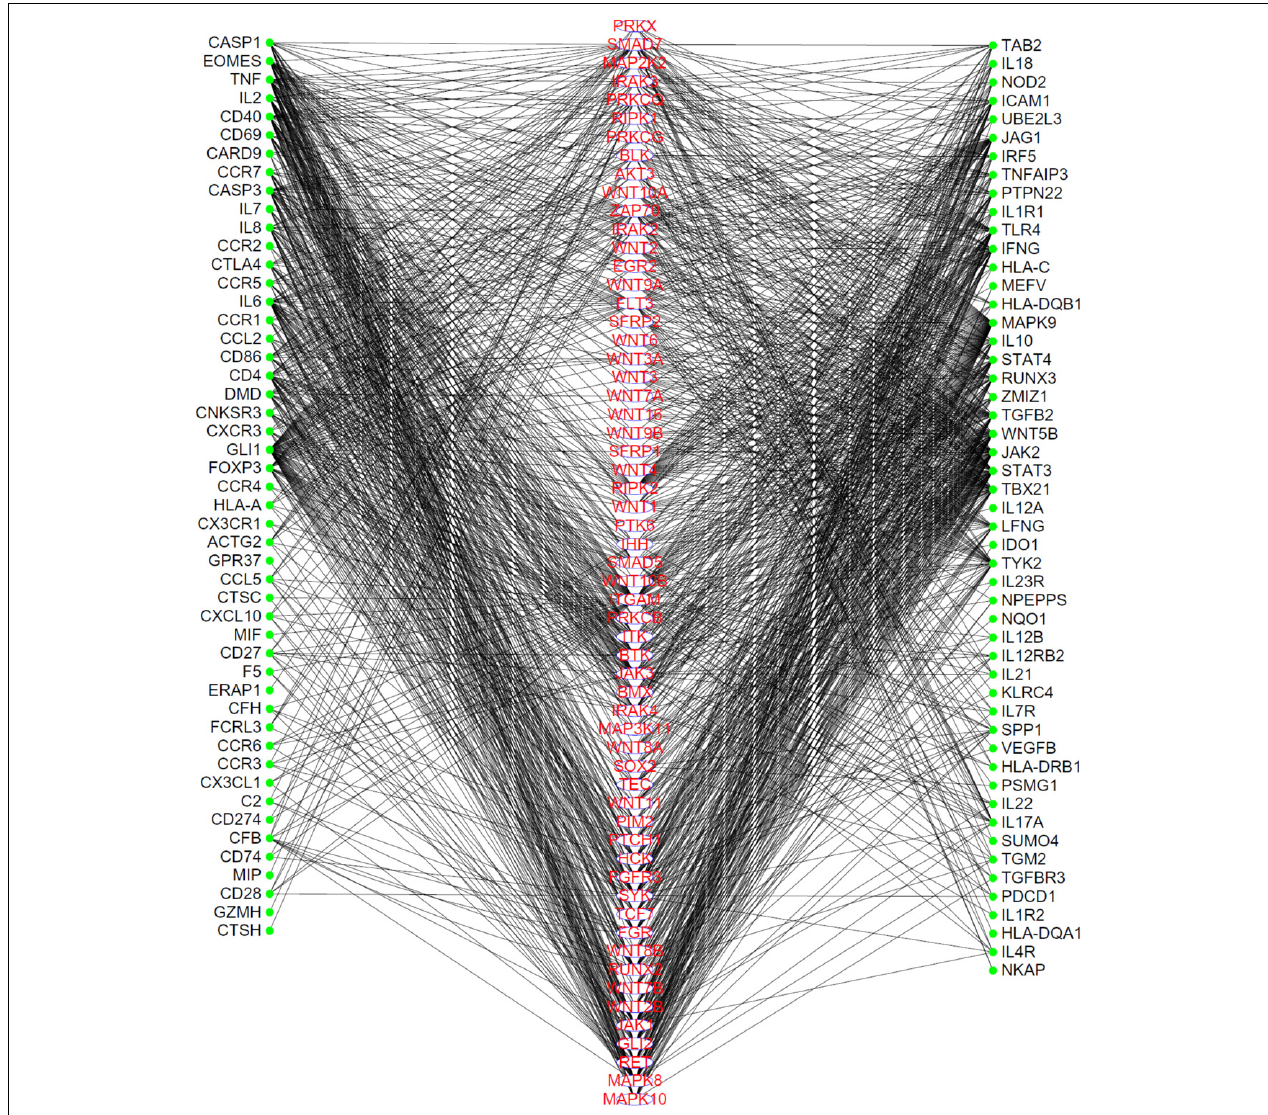
FIGURE 2 | The linkages between inferred uveitis-related genes and validated ones, which were extracted from the PPI network in STRING. Genes in the middle column are inferred genes, while genes in the left or right columns are validated genes. Each inferred gene has strong associations to validated